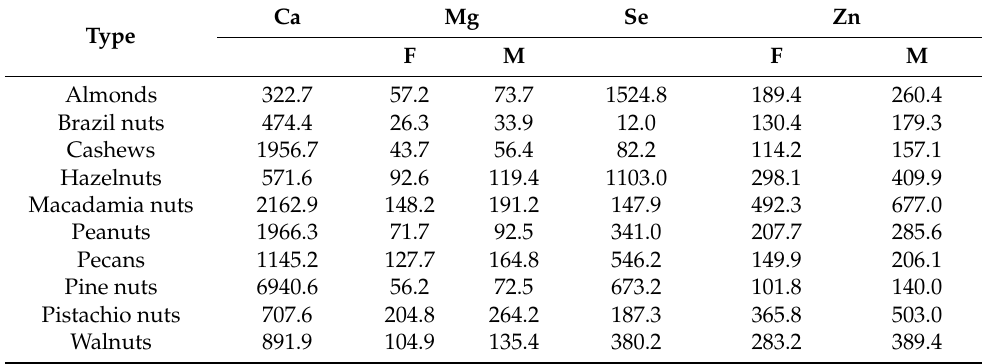
Table 3. The amount of nuts (g) that covers 100% of the recommended dietary allowance (RDA).